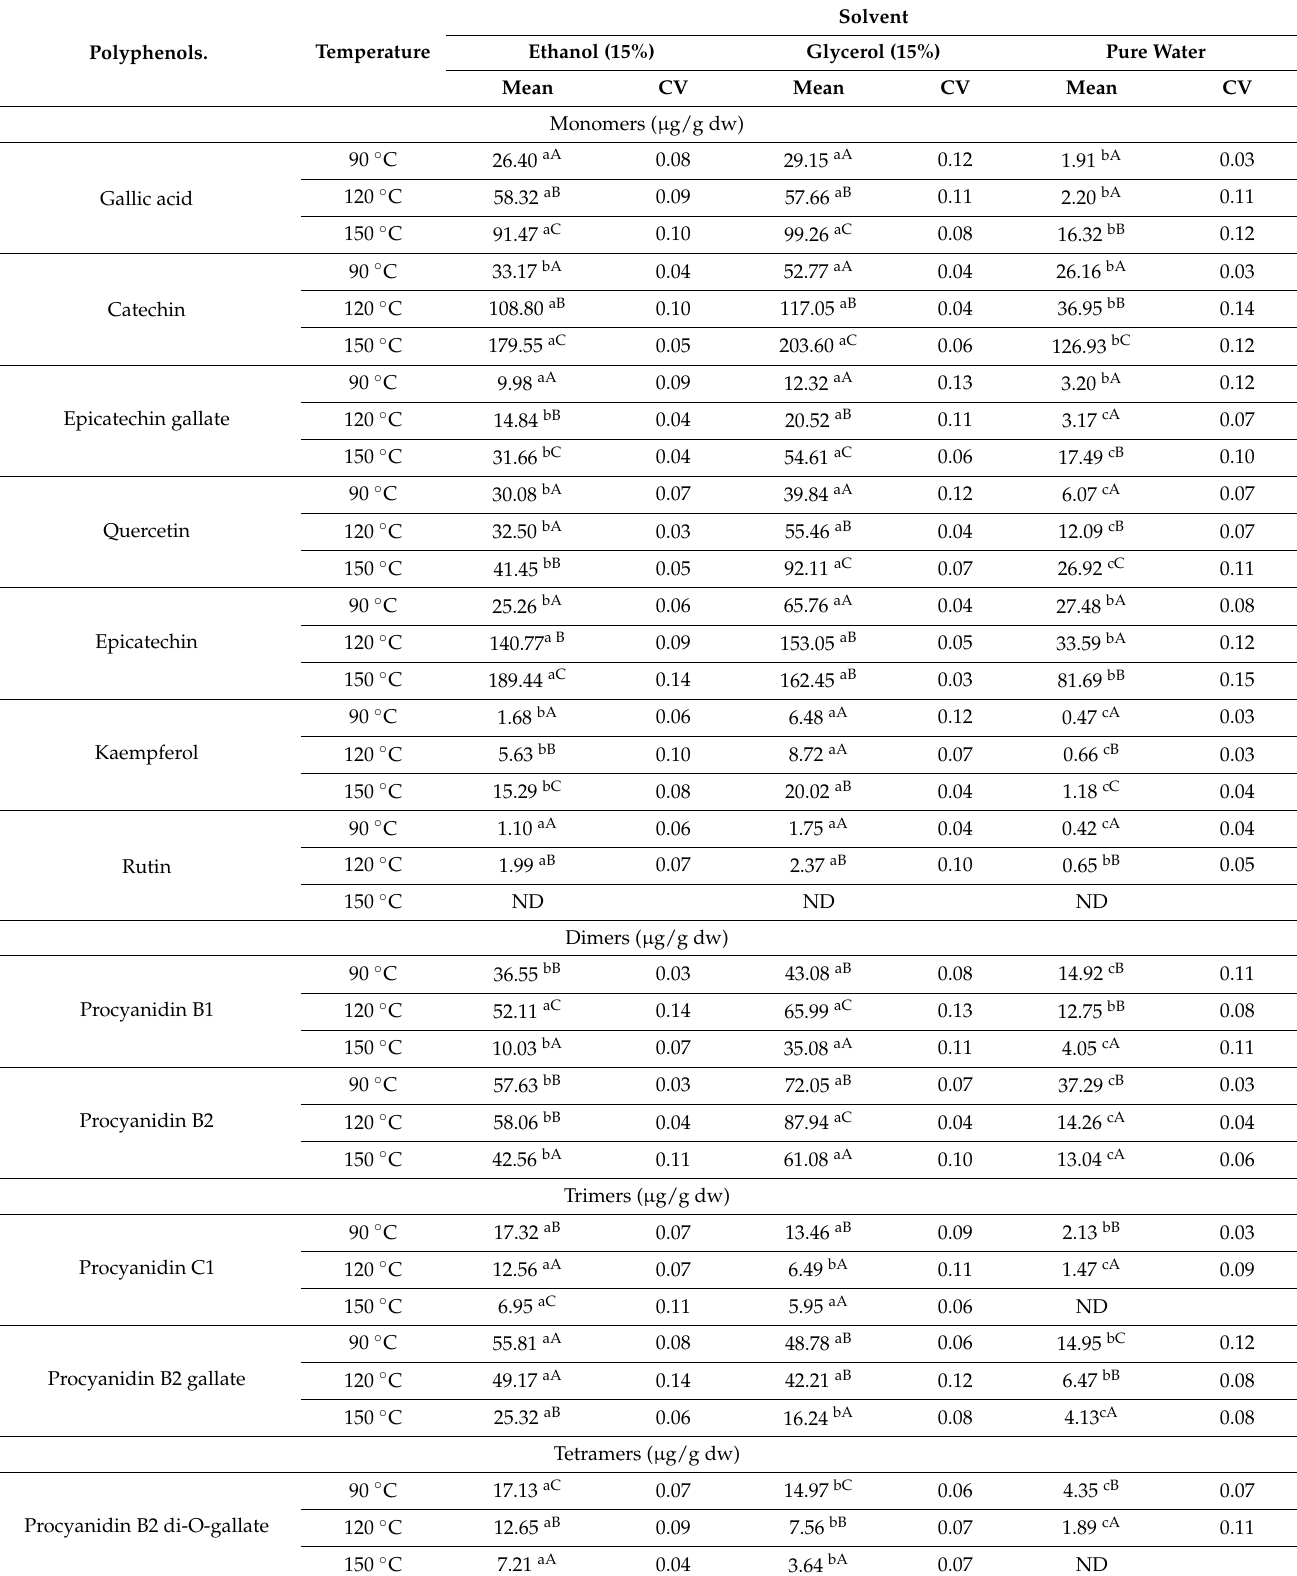
Table 3. Profile of the specific polyphenols obtained by